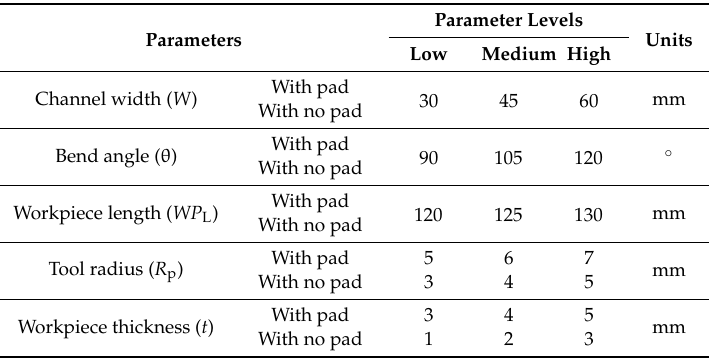
Table 2. U-geometry parameters and their